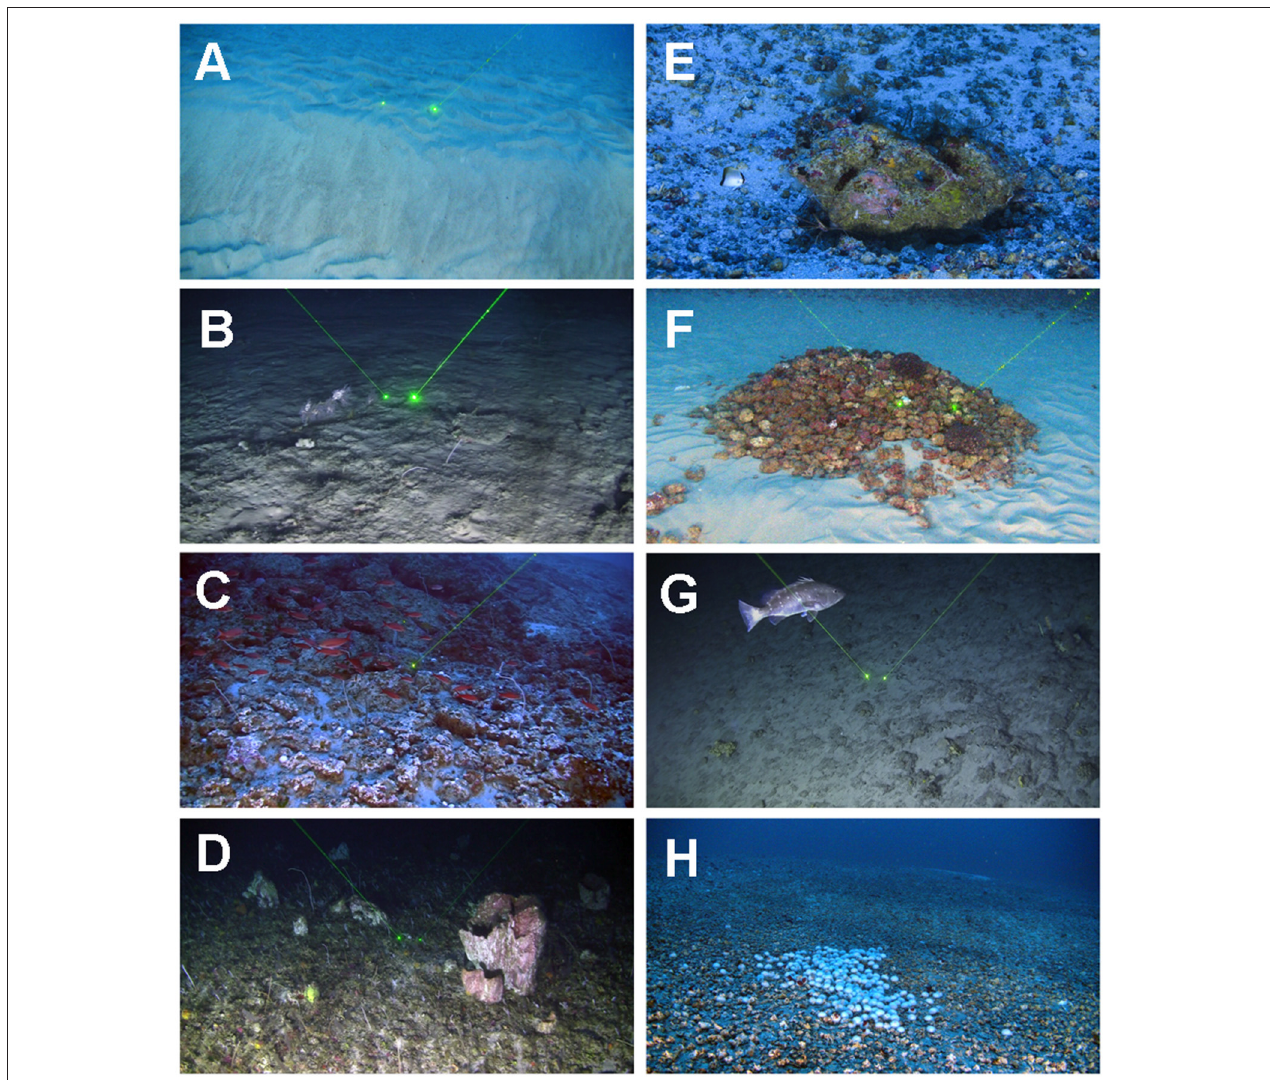
FIGURE 1 | Geodiversity and biodiversity of the GARS. Major structures along the inner and outer shelves. (A) Sand dunes in the shallowest portion of the reef (60–70m), (B) Reef covered by sediments between 70 and 80m depth, (C) Diverse reef community with schools of Paranthias furcifer and bottom dominated by live crustose calcareous algae and black corals at 130m depth, (D) Deepest portion of the GARS (220m) with nearly 100% of live benthic coverage (mostly sponges, octocorals and black corals), (E) A cleaning station of the Peppermint shrimp Lysmata grabhami at 110m depth, (F) Rhodolith mound built by the Sand tilefish Malacanthus plumieri at 130m depth, (G) A large individual ( > 60cm Total Length) of the commercially important and threatened snowy grouper Hyporthodus niveatus at 190m depth and (H) an urchin barren at 130m depth. Laser scale: